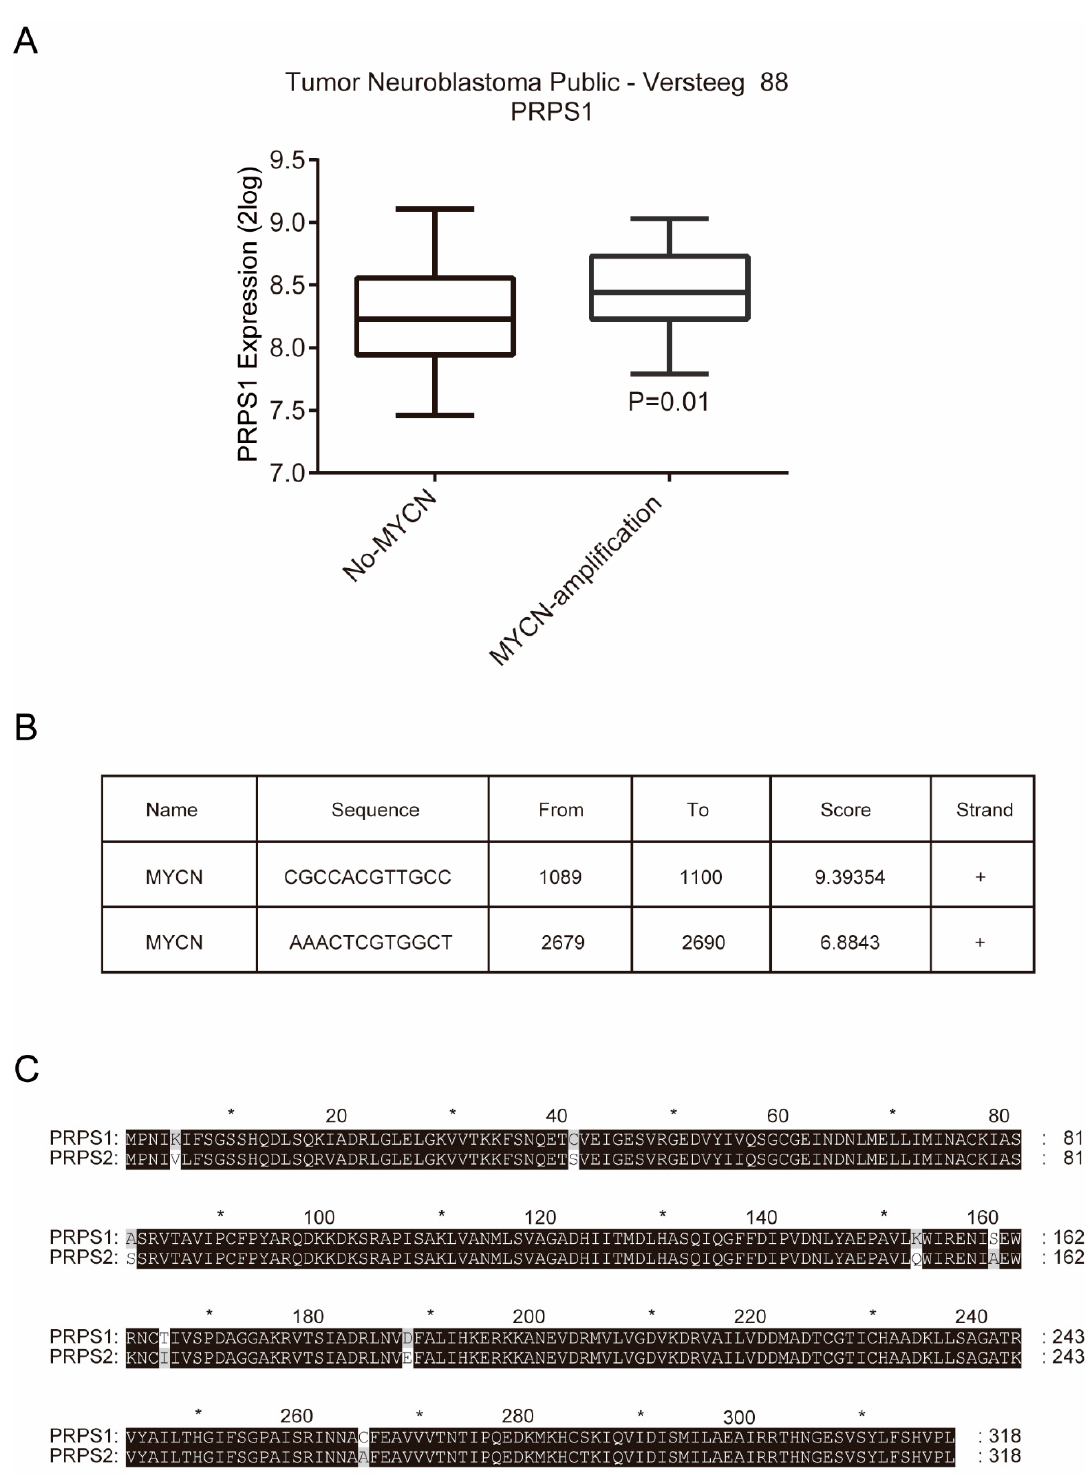
Figure 6. PRPS1 is closely related to MYCN in neuroblastoma patient. ( A ) The relationship between PRPS1 expression and MYCN amplification, based on data from the R2 platform. ( B ) The potential MYCN binding sites in human PRPS1 gene, based on data from the JASPAR database. ( C ) The amino acid sequence conservation of PRPS1 and PRPS2.